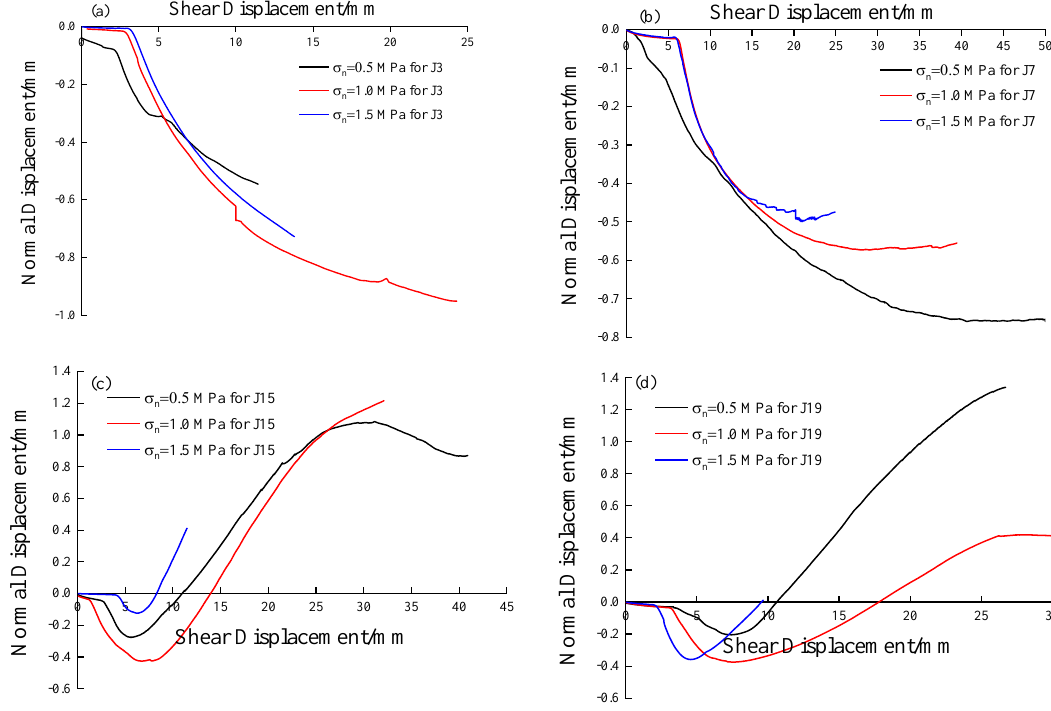
Fig.10. Normal displacement versus shear displacement curves of joints filling w ith liquid soil. Figure 10: Normal displacement versus shear displacement curves of joints filling with liquid